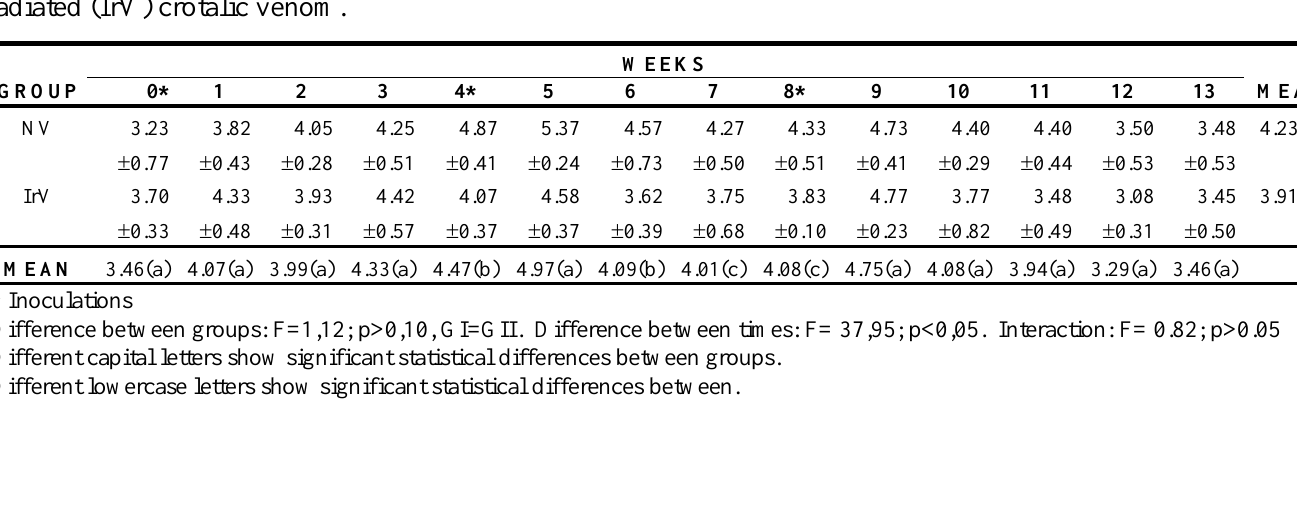
MEAN 3.43(a) 3.44(a) 3.46(a) 2.80(b) 2.79(b) 2.64(b) 2.87(b) 3.28(a) 3.21(a) 2.82(b) 2.97(b) 3.17(b) 3.50(a) 3.75(a) * Inoculations Difference between groups: F=0,59; p>0,50, GI=GII. Difference between times: F= 22,93; p<0,05. Interaction: F= 1.34; p>0.05 Different capital letters show significant statistical differences between groups. Different lowercase letters show significant statistical differences between times. Table 8. Means and standard deviation of globulin (g/dL) in sheep (n=12) inoculated at days zero, 30, and 60 with natural (NV) and Cobalt irradiated (IrV) crotalic venom.